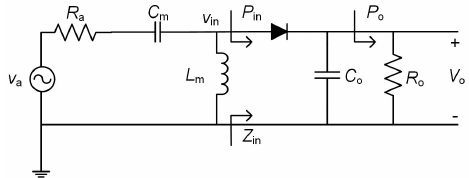
Figure 2. Proposed rectenna.